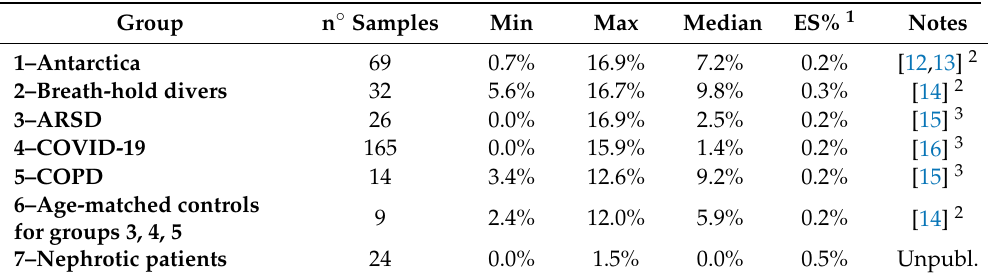
Figure 6. Replicate measurement of glutathionyl-hemoglobin ( ⚫ ) and of glycated hemoglobin ( ) in 23 samples of a human red blood cell hemolysate. Shown are the least-squares regression lines of the second replicate (R2) vs. the first replicate (R1) for both hemoglobin forms. Representative measurements of the four sample groups are reported in Table 2. Table 2. Summary of the results from the measurement of glutathionyl hemoglobin in RBCs of subjects belonging to different study